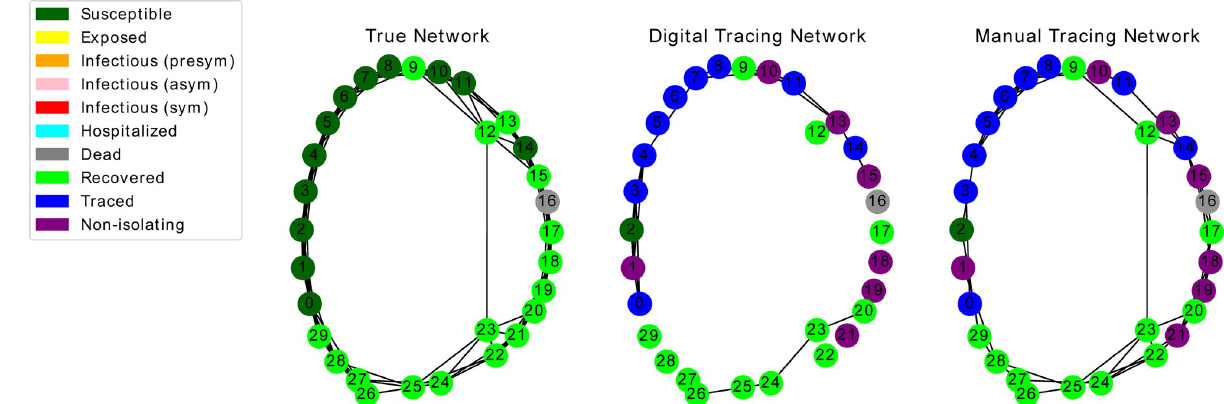
Fig 3. Final state of an epidemic simulation over a triad topology. Infection spreads with respect to the neighborhoods of the first network (here a SW graph); the second network corresponds to digital tracing at uptake r = 0.5, while the third involves manual tracing with overlap Γ = 0.5.